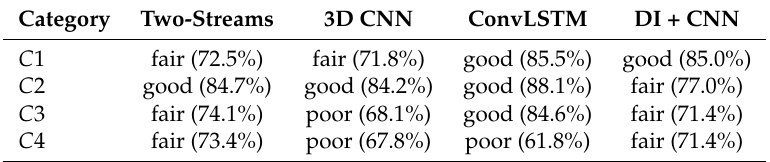
Table 1. Performance evaluation of the two-streams, 3DCNN, CNN+RNN (ConvLSTM) and